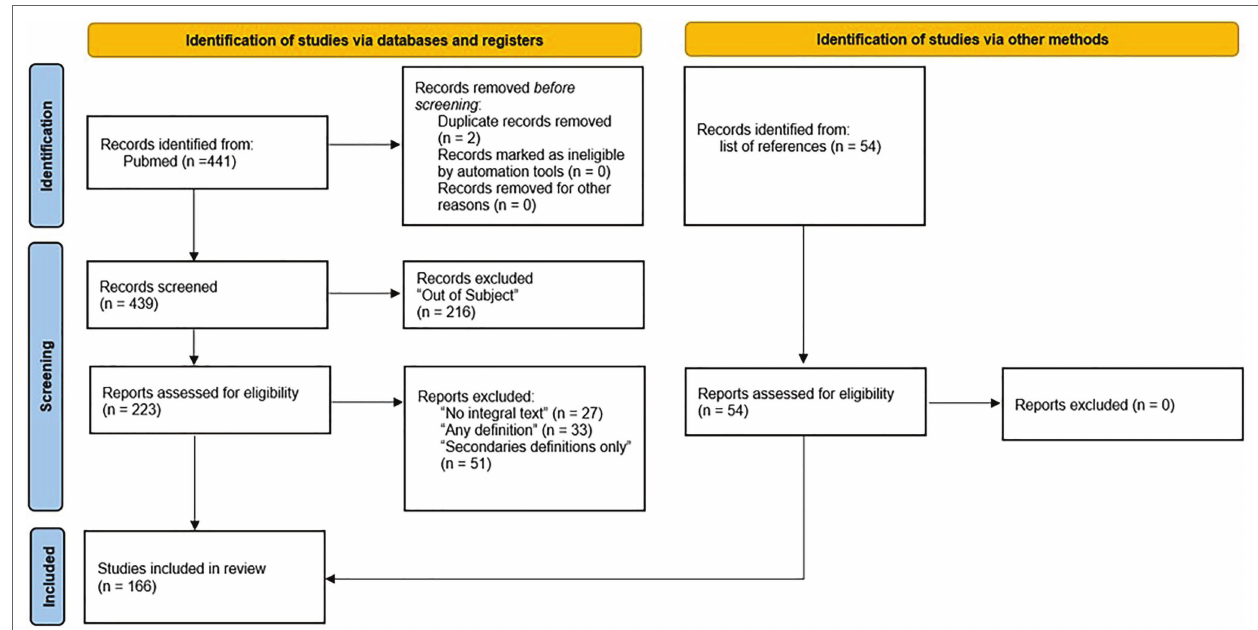
FIGURE 1 | PRISMA search strategy used in the present